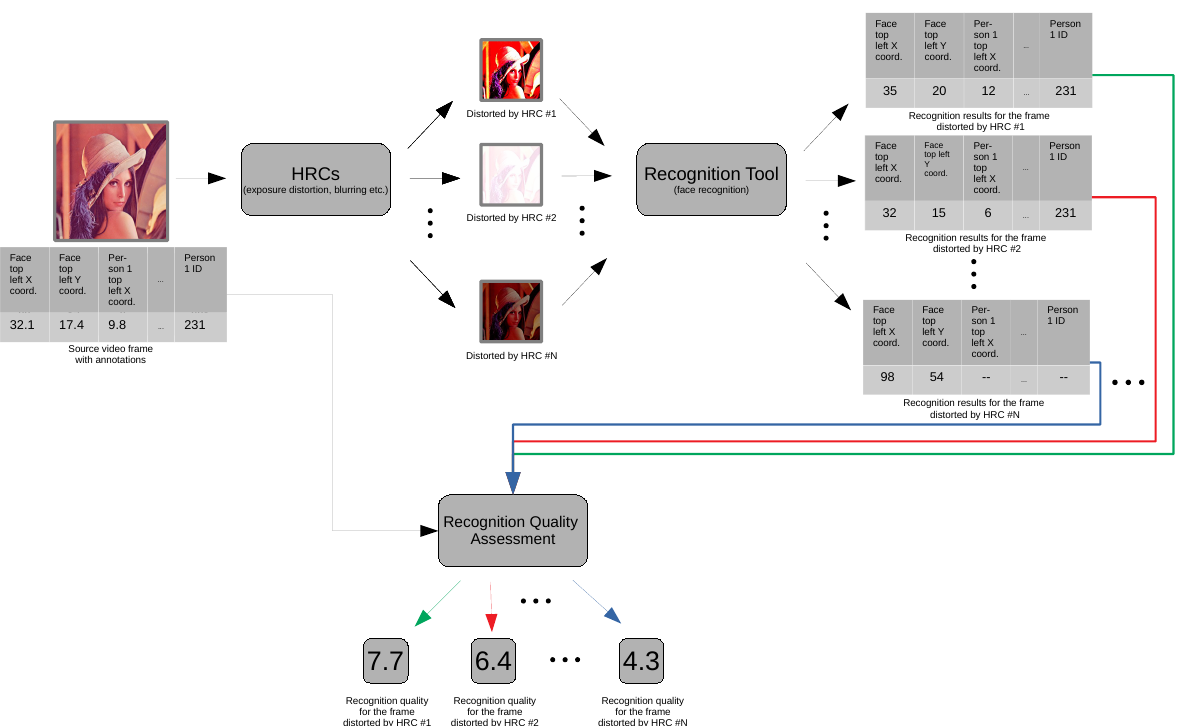
Figure 5. A flowchart presenting a processing pipeline of the recognition experiment.